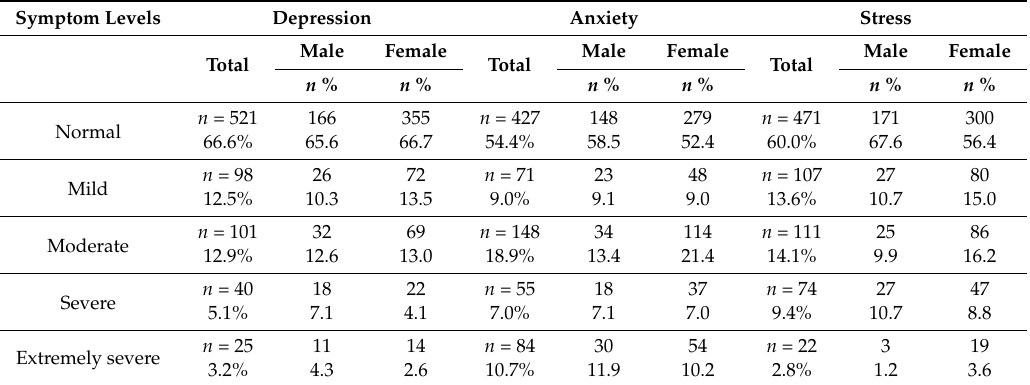
Table 4. The scores of depression, anxiety, and stress with respect to students’